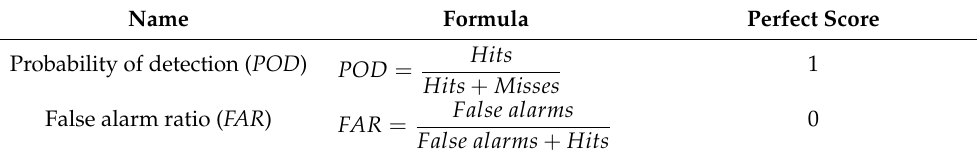
Table 2. List of categorical verification metrics used to evaluate IMERG products.